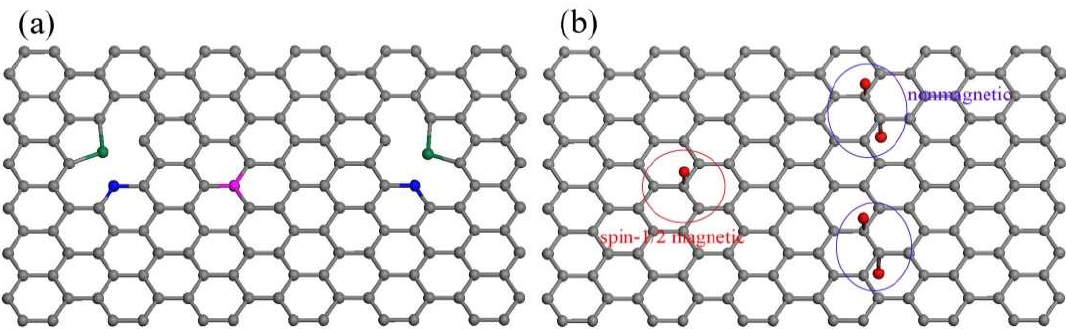
Figure 5. Schematic representation of ( a ) NG and ( b ) sp 3 -NG. Carbon atoms are grey. Pyridinic-, pyrrolic- and graphite-N atoms are blue, green, and magenta, respectively. The red balls denote the amino groups (-NH 2 ) covalently bonded to the basal-plane carbon atoms. In the red oval region there is an isolated amino group and in blue ones two amino groups chemisorbed on different sublattices to form AB dimers.